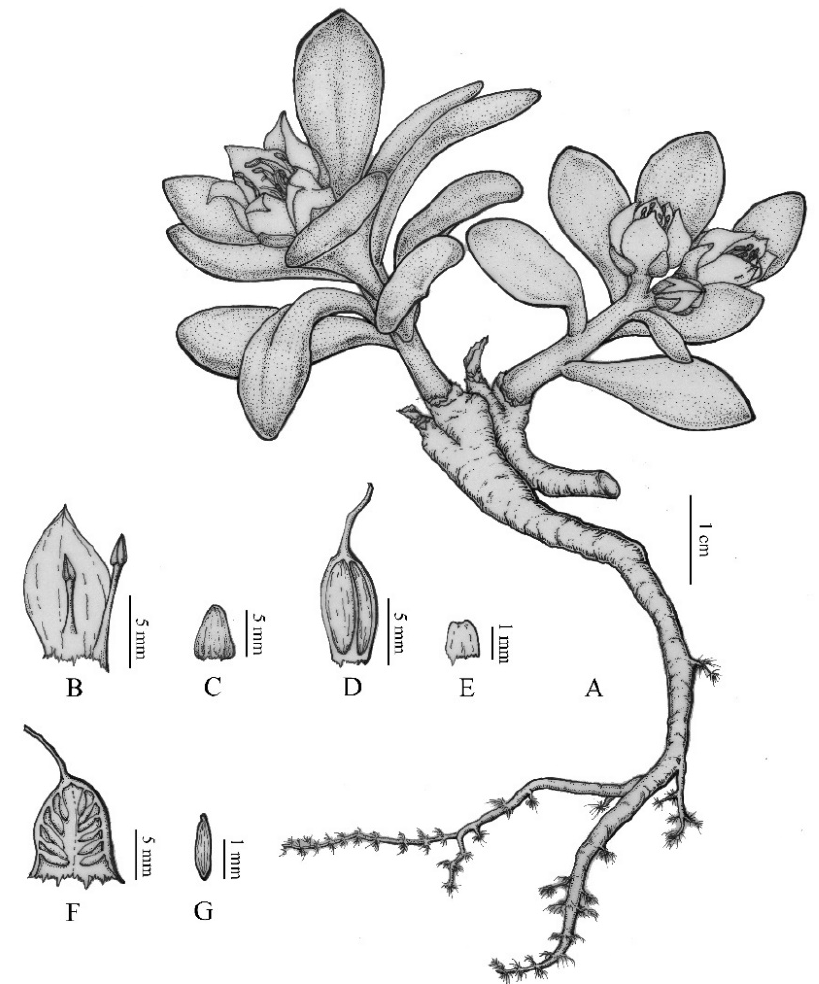
Figure 7. Rhodiola namlingensis S.Y. Meng. ( A ). Rhizome and flowering stem; ( B ). Petal and stamens; ( C ). Sepal; ( D ). Carpel; ( E ). Nectar; ( F ). Follicle; ( G ). Seed. Drawing by Ye Lv from PEY0067595.